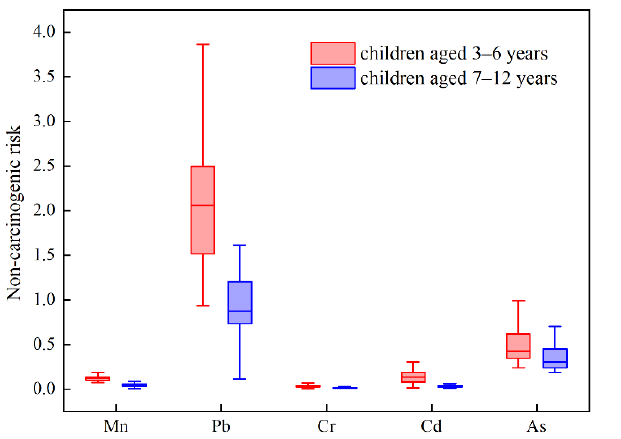
Figure 2. The non-carcinogenic risk of each metal(loid) exposure via ingestion for children aged 3–6 years and 7–12 years, respectively.